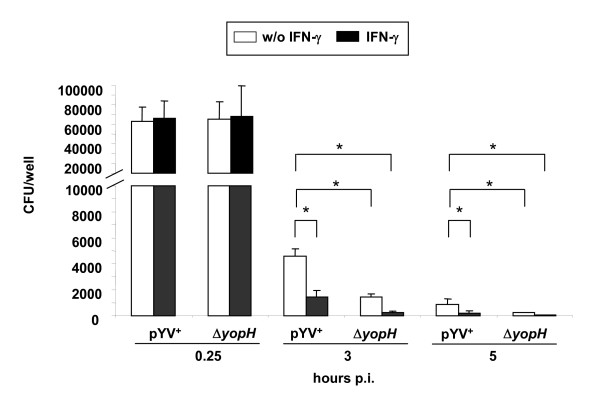
Survival of bacteria in BMDM. BMDM were either pretreated or not pretreated with IFN-γ (50 ng/ml) for 24 h and subsequently infected with pYV+ or ΔyopH with a MOI of 5 (C) for 0.25 or three hours as described in Material and Methods. Numbers of bacteria were determined by a CFU assay. The data represent the CFU ± standard deviation of three independent experiments. All groups were compared for one point in time and asterisks indicate significant differences between the compared groups (p < 0.05, one-way ANOVA with Bonferroni correcctions).